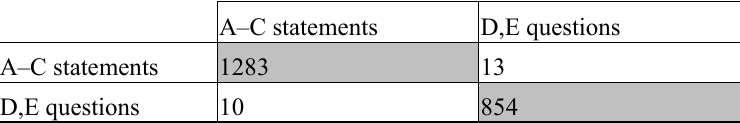
Table 2. Recognition of statements and of